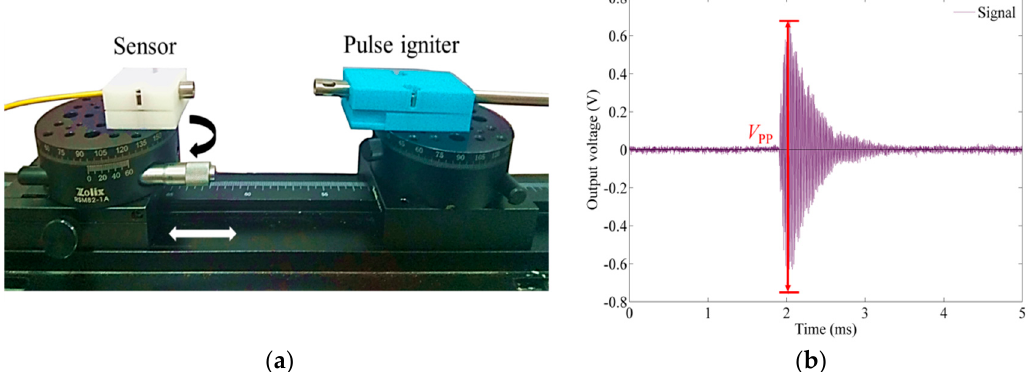
Figure 5. ( a ) Photograph of the experimental setup; ( b ) The detected ultrasonic signal from the pulse igniter.